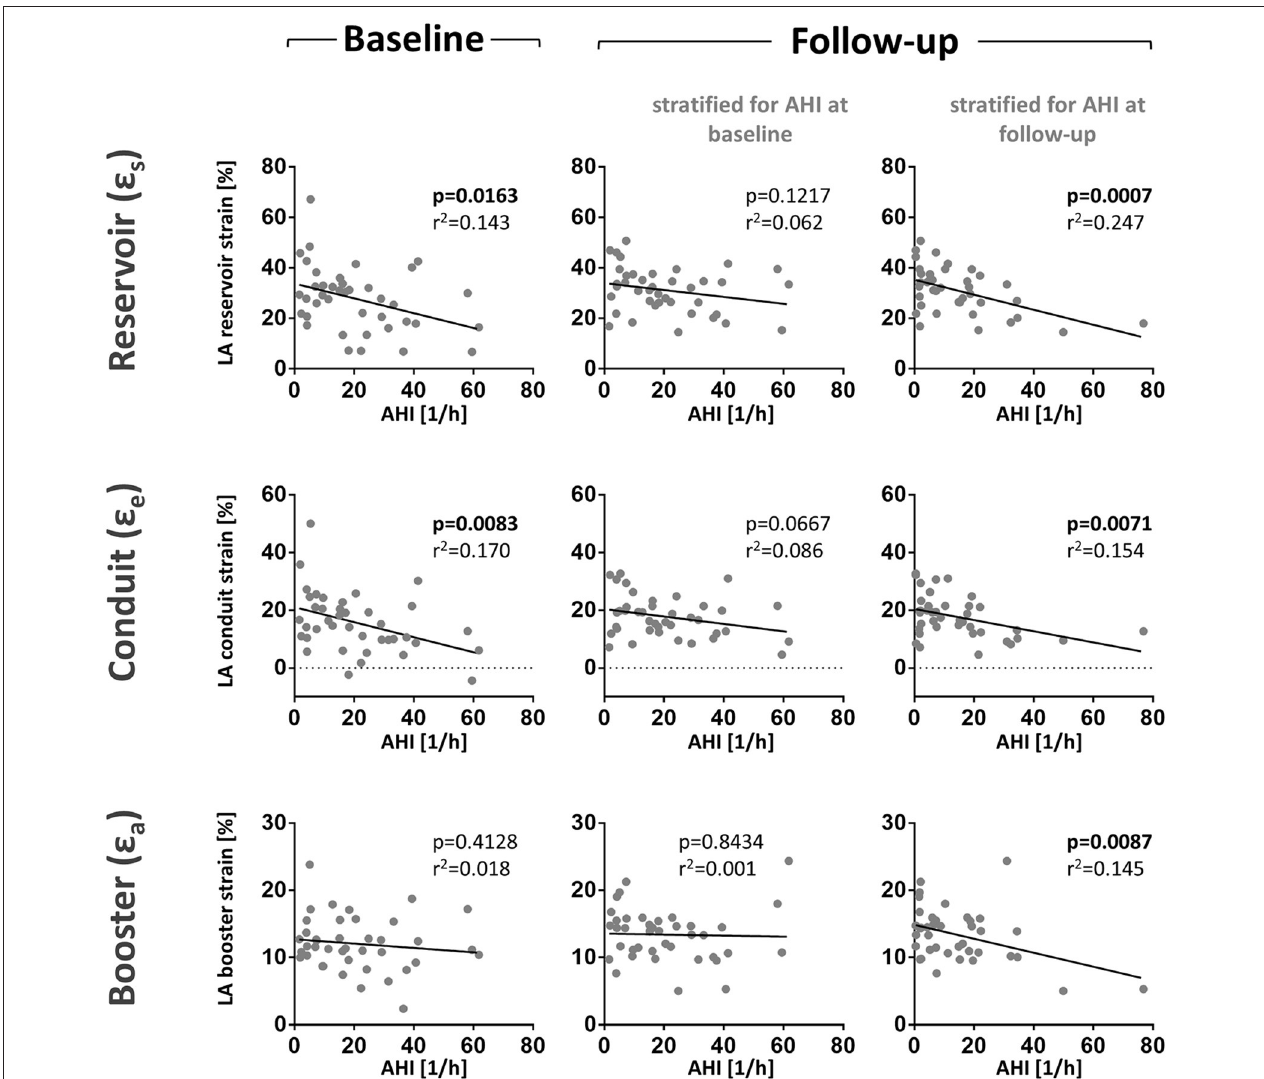
FIGURE 3 | LA function correlates negatively with the apnoe-hypopnoea-index (AHI). Shown are scatter plots of AHI and LA reservoirs, conduit, and booster strain at baseline and follow-up. We performed two analyses for the follow-up data. First, patients were stratified patients for AHI measured at baseline to evaluate the intra-individual development of SDB and strain over time (middle panel). In this stratification, the correlation of AHI and LA reservoir strain was lost at follow-up. Second, patients were stratified for AHI measured during follow-up to assess the influence of AHI on LA strain (right panel). In this stratification, the negative correlation between AHI and La reservoir strain was highly significant. These results show that the AHI may be the main predictor of LA reservoir strain in contrast to other individual factors. Correlation scatter plots include p -values (bold letters signify statistical significance p < 0.05) and adjusted R 2 -values.